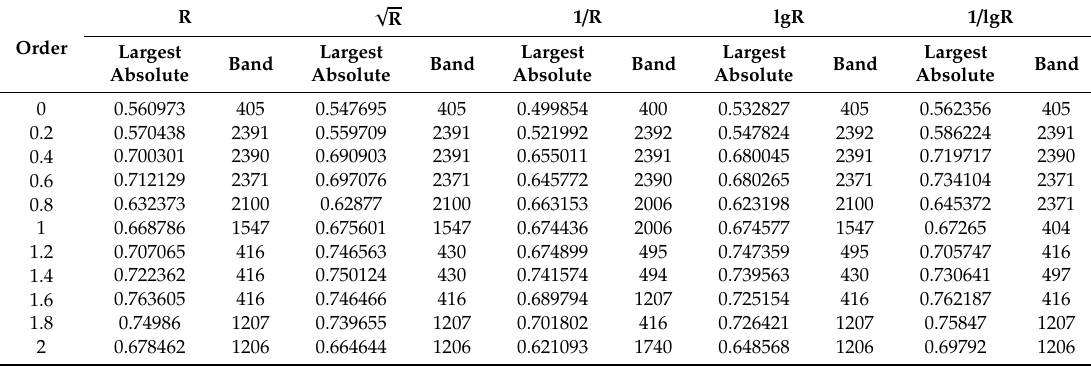
Table 1. Bands with the largest absolute values of correlation coefficients under five spectral transformation.